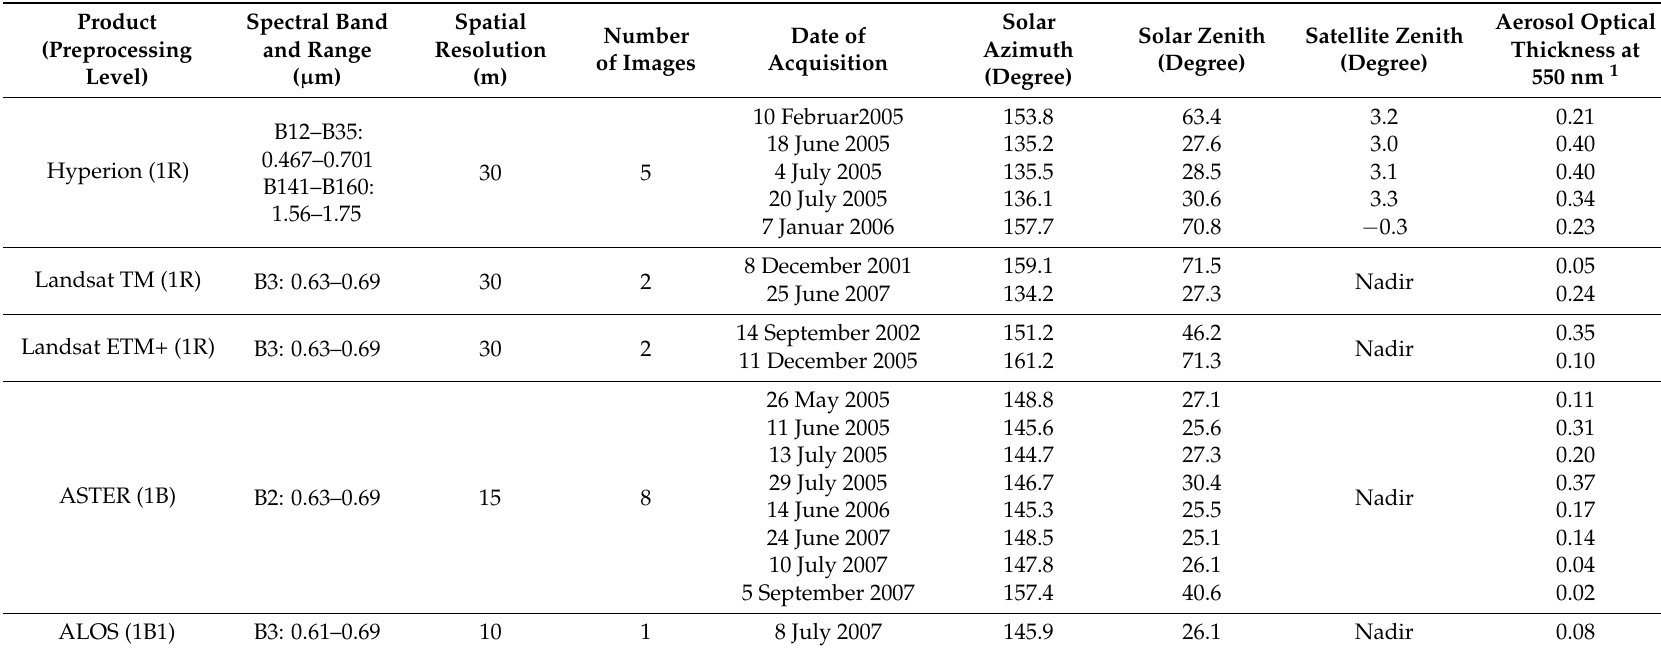
Table 1. Satellite data used in this